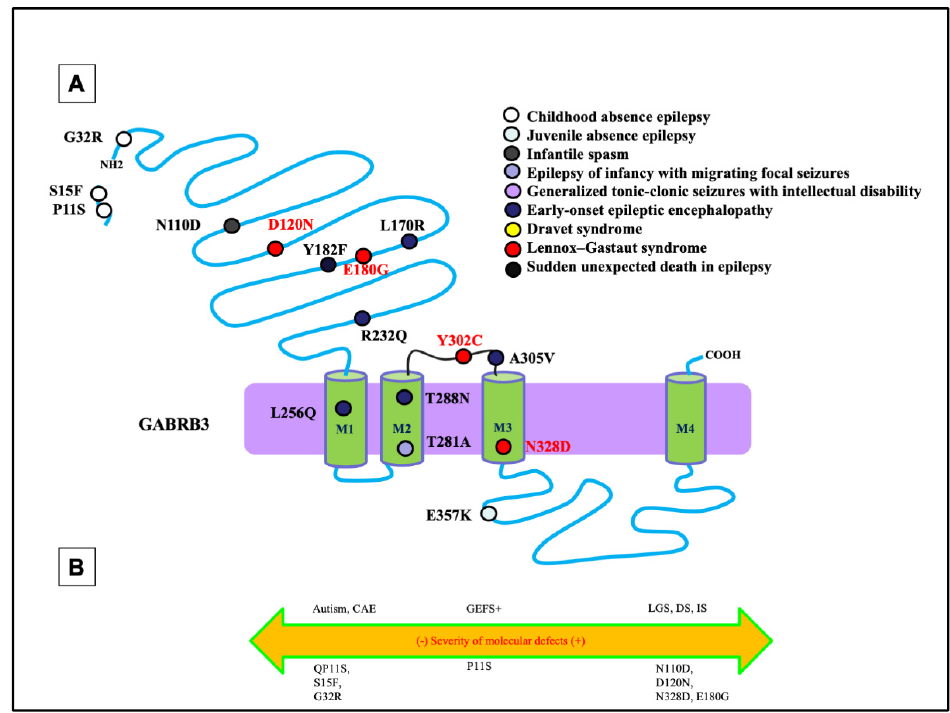
Figure 4. Epilepsy phenotype associated GABRB3 mutations. ( A ) Two-dimensional protein topology of the β 3 subunit showing relative locations of mutations in human GABRB3 associated with various epilepsy syndromes and neurodevelopmental disorders. Each mutation is color coded to indicate associated diagnosis, and each dot represents the β 3 subunit protein peptide. ( B ) Diagram dictating the severity of each mutation on a continuum of epilepsy phenotypes. The left side of the diagram infers a less severe epileptic phenotype, the middle dictates a moderate, and the right side of the diagram infers a more severe epileptic phenotype.